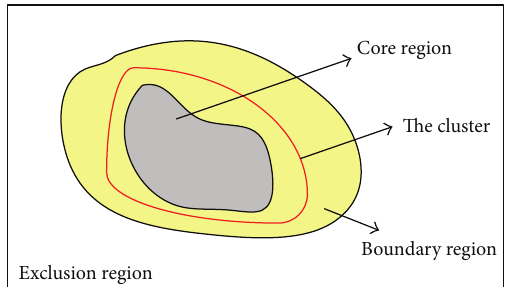
Figure 3: Three levels of belongingness with respect to a cluster.